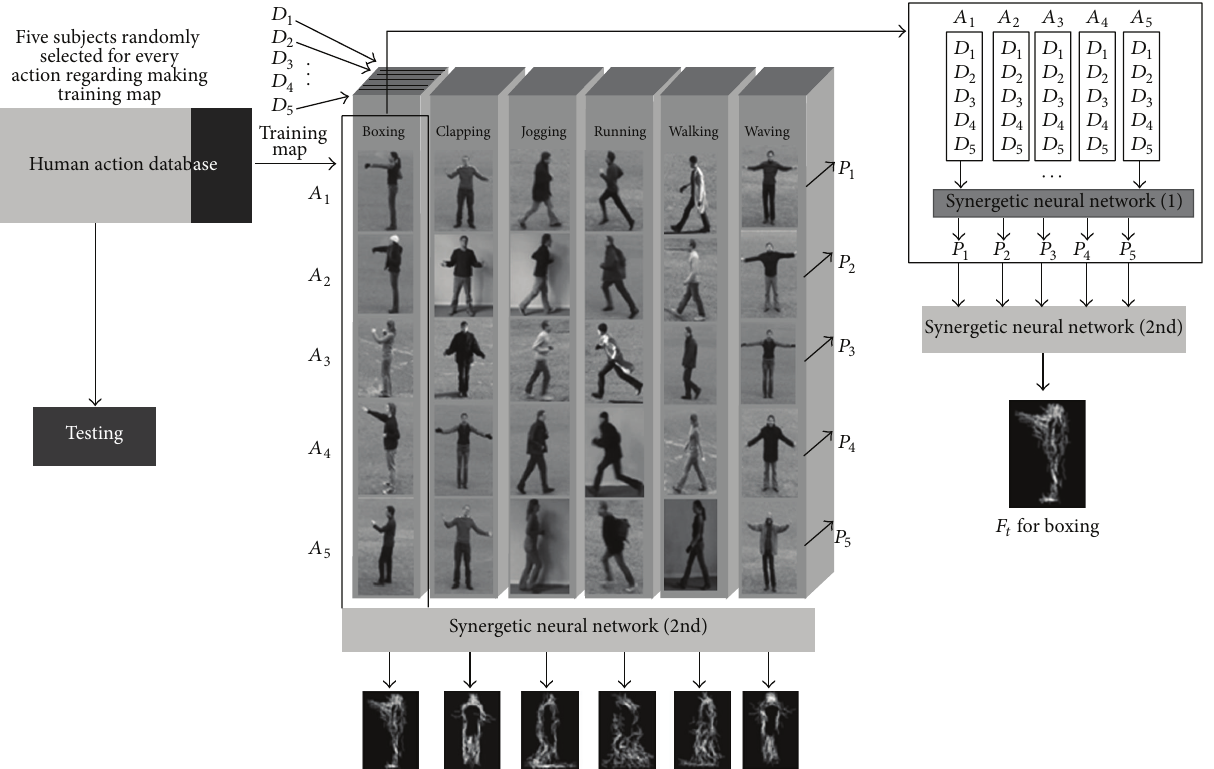
Figure 5: The figure shows procedure of making the action active basis templates by applying two times synergetic neural networks melting on the training map which calculates from randomly selected video frames from KTH human action database